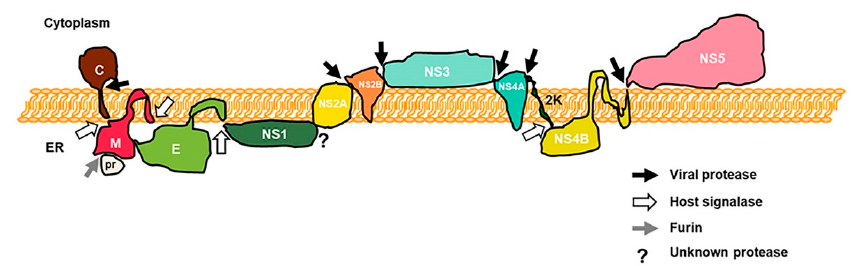
Figure 1. Schematic of a flavivirus polyprotein in the endoplasmic reticulum (ER). Capsid (C), prM, and envelop (E) proteins facilitate viral entry and maturation, while the other seven nonstructural (NS1, NS2A, NS2B, NS3, NS4A, NS4B, and NS5) proteins are responsible for viral replication, viral particle assembly, and maturation. Viral and host proteases cleavage sites are indicated by arrows. NS4A C-terminaltransmembranedomain2Kisalsoshown(adaptedfromJ.RRodriguez-Madoz,